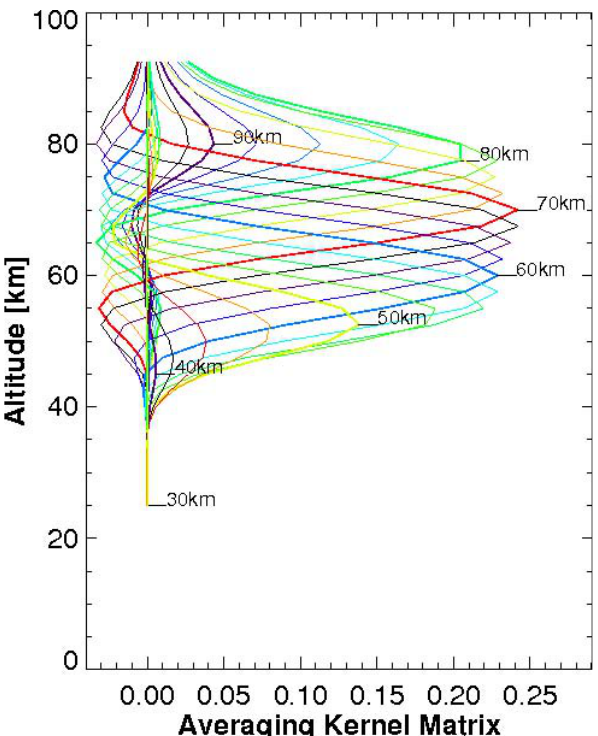
Fig. 1. Typical averaging kernels for observations of the tides. Due to the long integration time ( ≈ 180h) the instrument is almost as sensitive at 80km as at